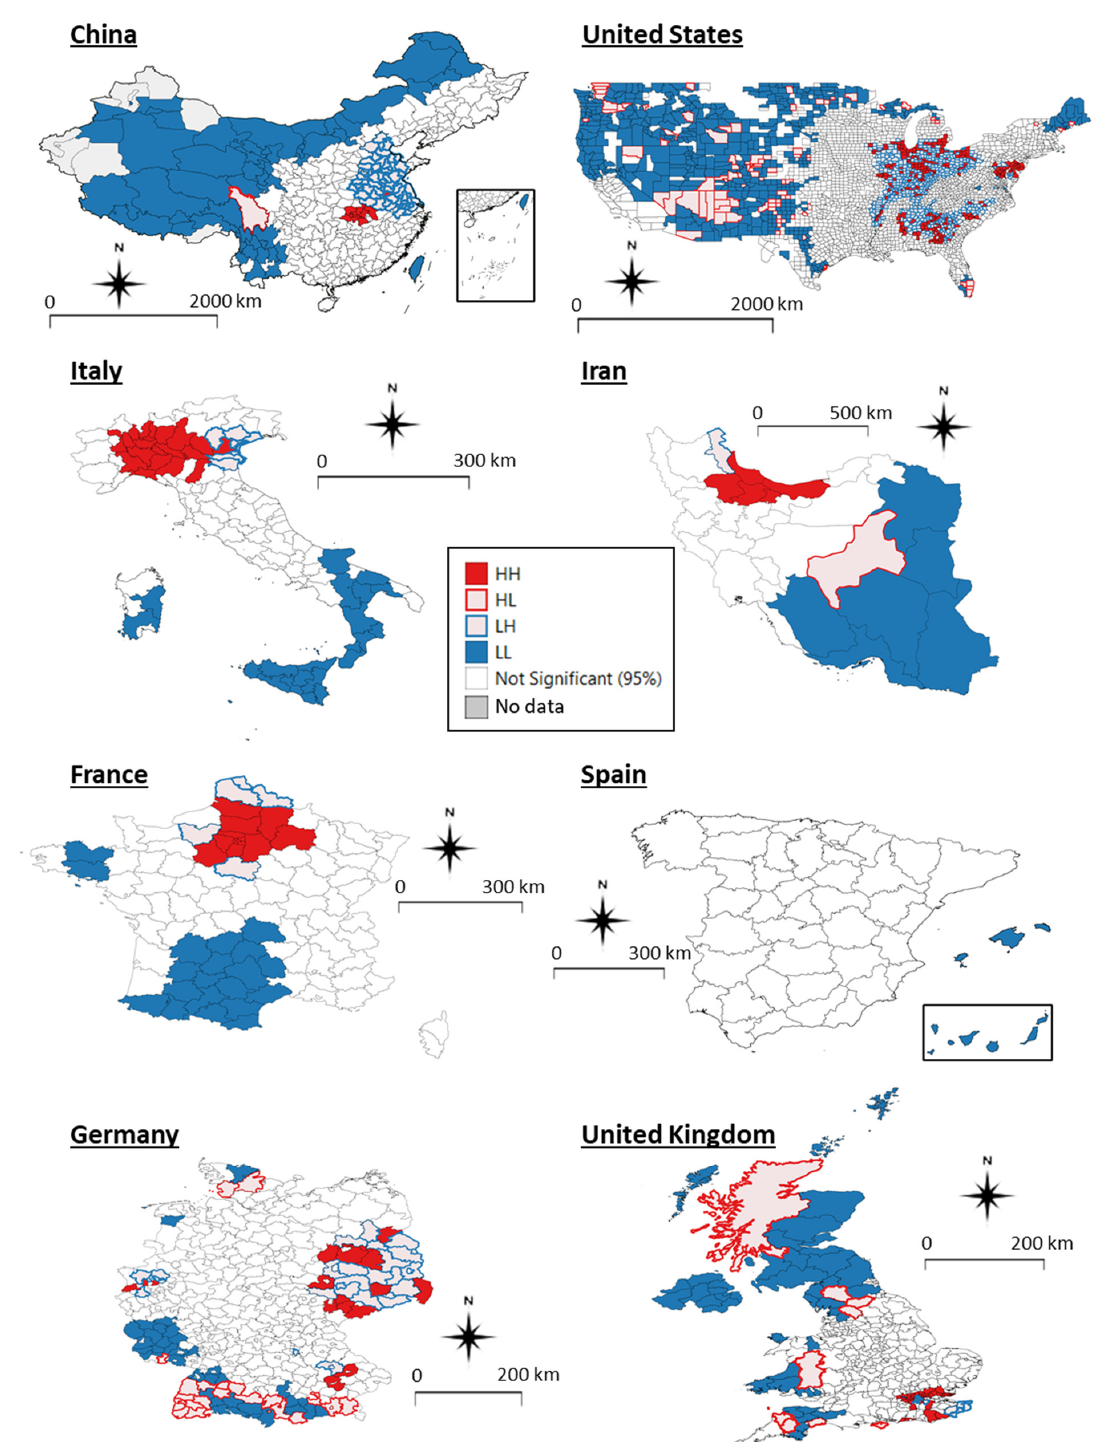
Figure 2. Maps of clustered, adjacent administrations resulting from Local Moran Bivariate analysis. Four types of significant spatial relationships exist. HH in filled red: High COVID-19 (infections, deaths, or mortality rates) and High PM 2.5; HL in empty red: High COVID-19 and Low PM 2.5; LH in empty blue: Low COVID-19 and High PM 2.5; LL in filled blue: Low COVID-19 and Low PM 2.5. While HH and LL filled coloured clusters support the COVID-19/air pollution correlation hypothesis, HL and LH empty colours represent spatial outliers in which air pollution does not explain the virus’ presence. Note that the COVID-19 variables used in each country are those of Figure 1. Data sources can be found in Table 1.